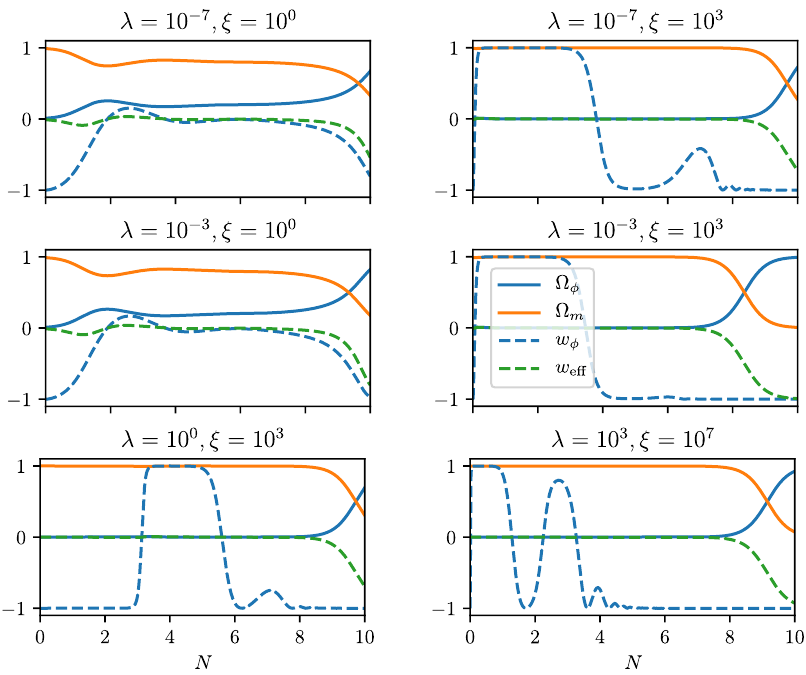
Figure 3 . Evolution of the scalar field parameters (4.10) following from the system (4.11)–(4.13), for w = 0 and different values of λ, ξ . We denoted Ω m = 1 − Ω φ . We choose initial x i , y i to have Ω φ < 0 . 2 initially and Λ i , or equivalently Φ i to obtain between 8 and 10 e-folds of matter